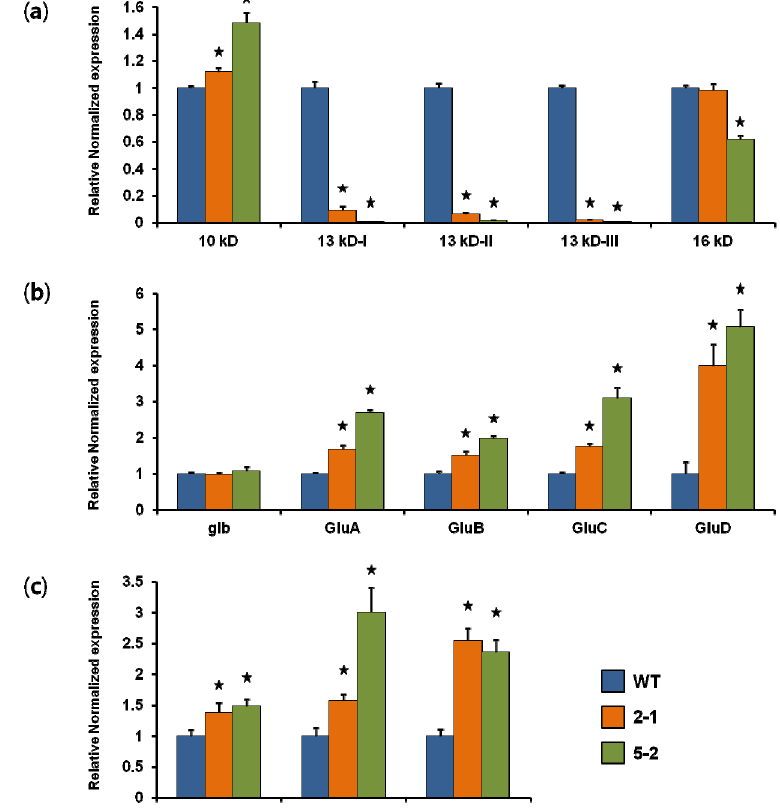
Figure 1. Transcript levels for the wild type (WT) and 13 kD pro-RNAi lines (2-1 and 5-2, respectively). Total RNA was extracted from immature seeds of WT or 13 kD pro-RNAi lines two weeks following flowering, reverse transcribed using oligo (dT) 15, and subjected to qRT-PCR using specific primers for prolamins ( a ), 10 kD, 13 kD-I, 13 kD-II, 13 kD-III and 16 kD; ( b ), α -globulin (glb), glutelins (GluA, GluB, GluC and GluD) and ER chaperone genes ( c ) BiP, PDI and CNX. The transcript levels were normalized to that of the internal control gene ubiquitin, and are represented relative to the expression levels in the WT. The values are means and SDs (error bars) of three replicates of the same RNA samples. The asterisks represent values significantly different from the wild type ( P < 0.05). The primers are listed in Table